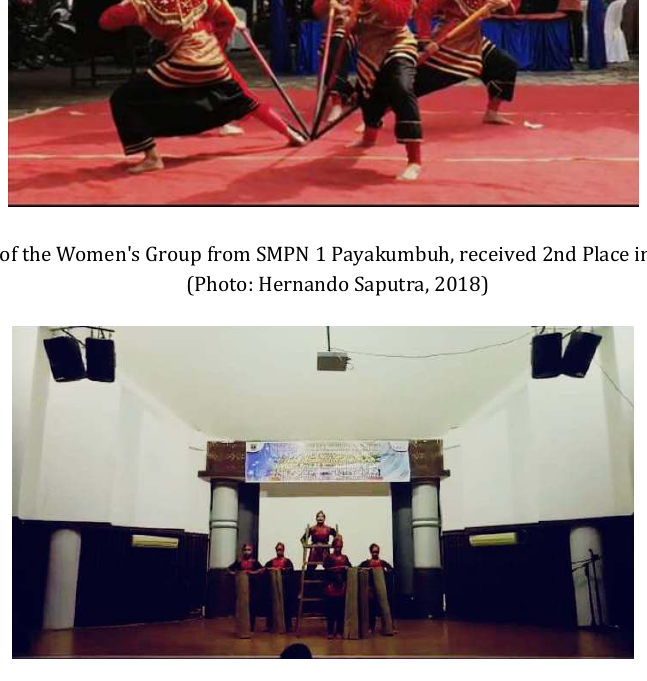
Figure 2. Participants of the Women's Group from SMP N 1 Payakumbuh City, Won 3rd Place at the West Sumatra Provincial Level FLS2N on August 4 2019 (Photo: Venny Rosalina,